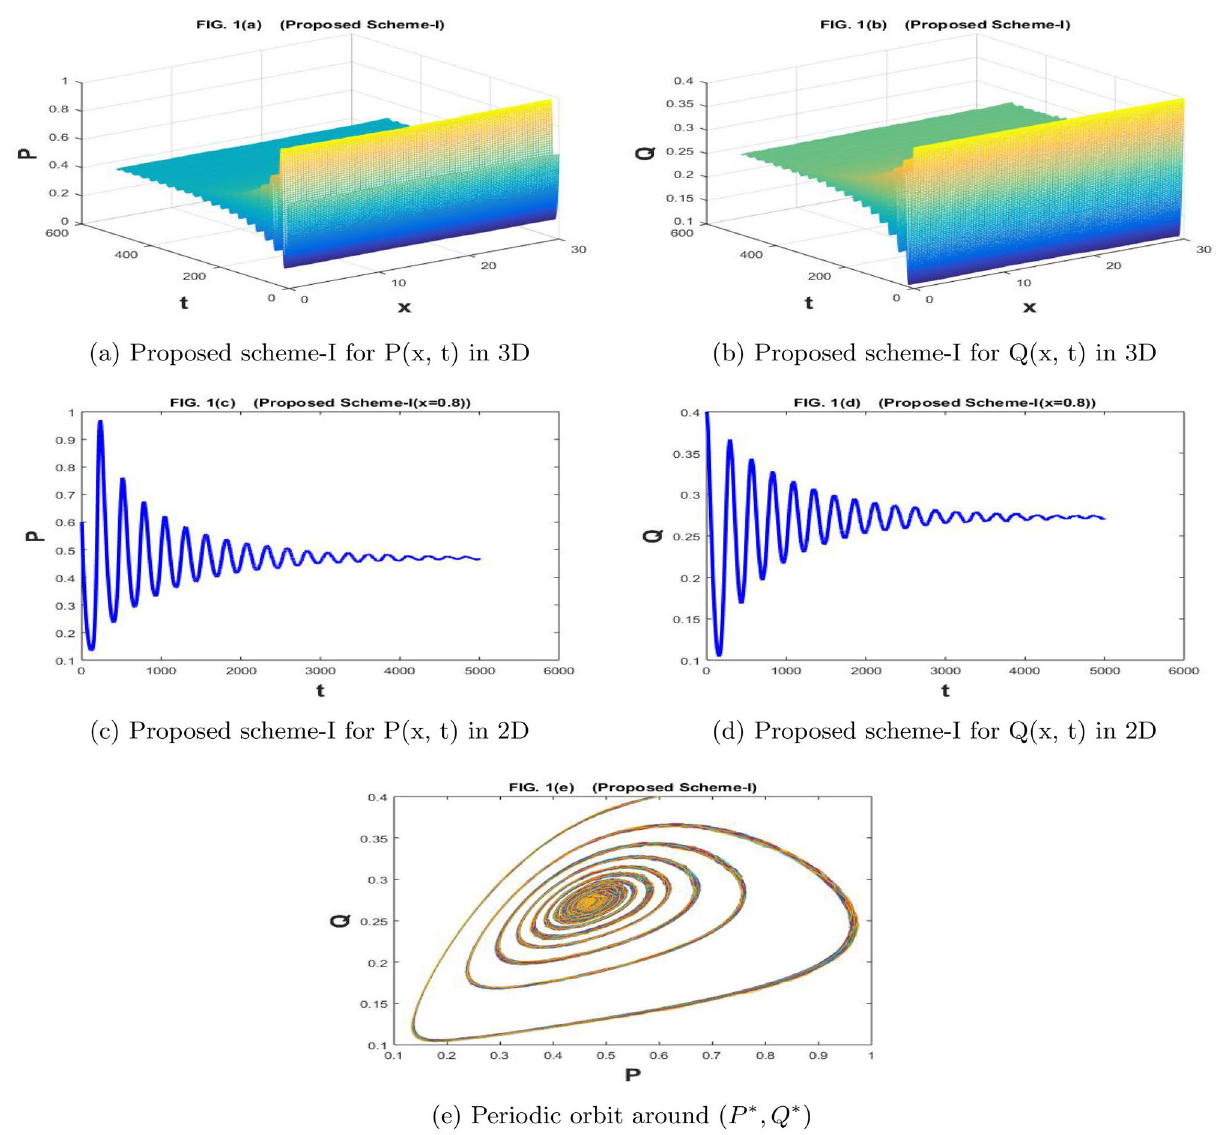
Figure 1. The subfig ( a and c ) and ( b and d ) represents the numerical approximation of P ( x , t ), and Q ( x , t ) respectively by proposed scheme-I. The subfig ( e ) represents the periodic orbit around ( P ∗ , Q ∗ )